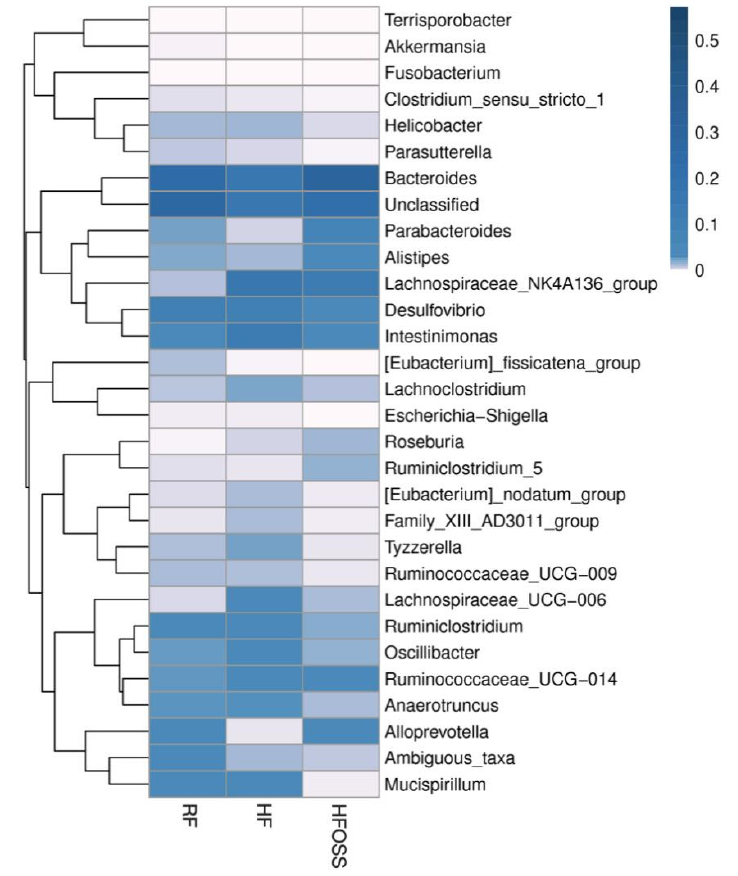
Figure 7. Genus distribution heatmap of the fecal microbiota of mice fed a regular-fat diet (RF), high-fat diet (HF), and high-fat diet supplemented with OS starch (HFOSS). The colors in the heatmap represent the relative abundance of the corresponding genus in the corresponding group.